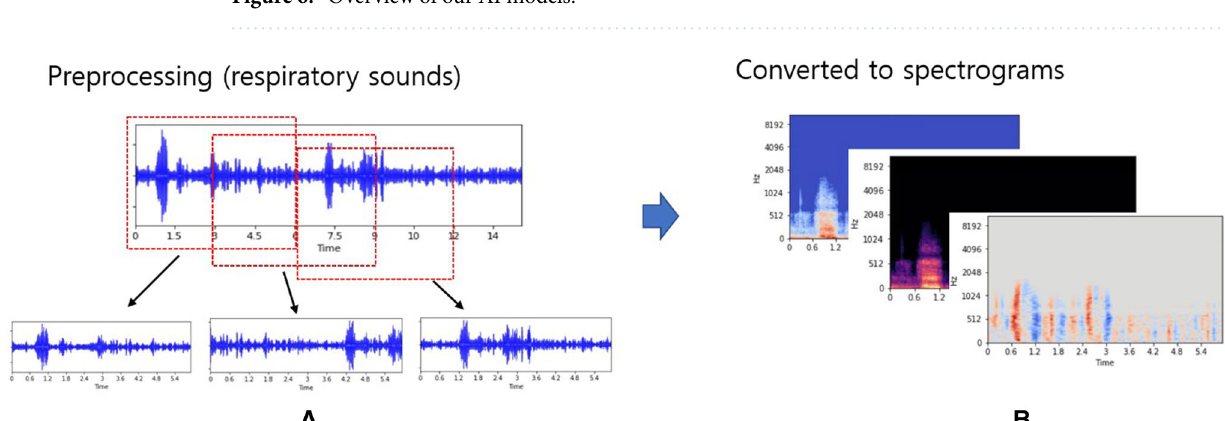
Figure 7. Process to obtain spectrograms. ( A ) Given lung sound, dividing lung sound files with overlapping during 3 s ( B ) Obtaining three types of Mel-spectrograms with